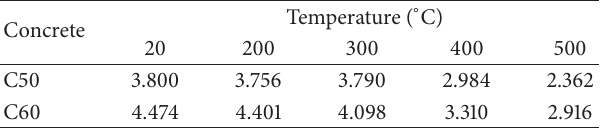
Table 4: The cleavage strength of HPC at elevated temperature (MPa).